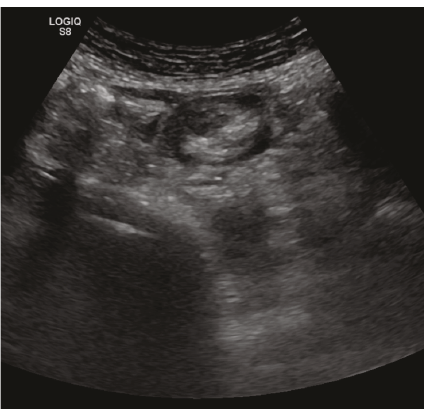
Figure 1: Abdominal ultrasound (possible intussusception).